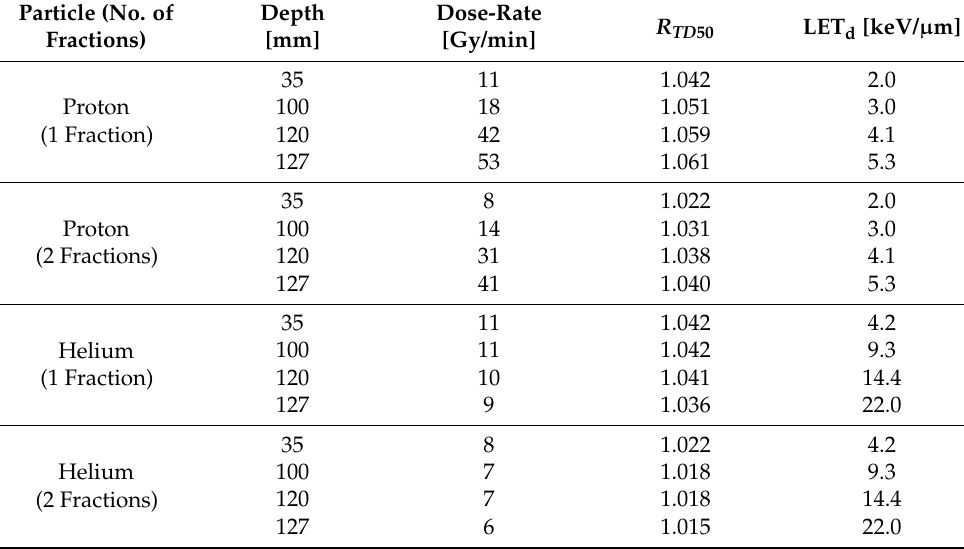
Table 3. Calculated dose rate, corresponding values of R TD 50 , and simulated dose-weighted LET (LET d ) for each measurement position of the proton and helium SOBP and fractionation scheme in the studies of Saager et al. [23] and Hintz et al. [24]. Particle (No. of Depth Dose-Rate R TD 50 LET d [keV/ µ m] Fractions) [mm] [Gy/min]